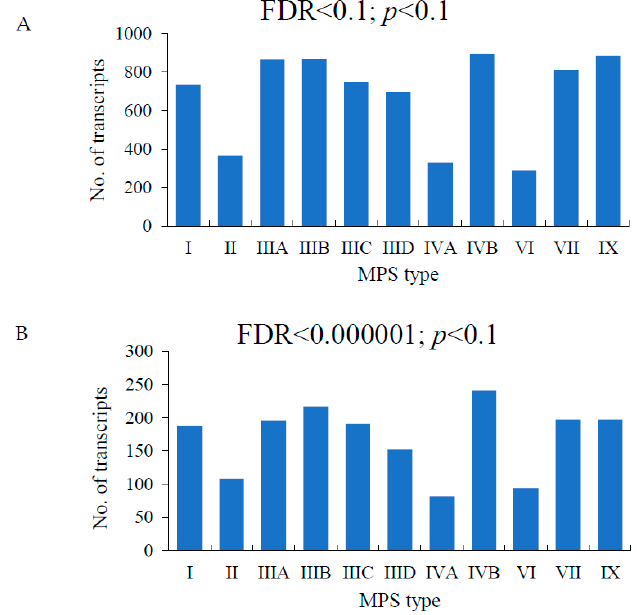
Figure 1. Number of transcripts with changed levels of expression (at FDR < 0.1; p < 0.1 ( A ) or FDR < 0.000001; p < 0.1 ( B )) in different types of MPS relative to control cells (HDFa). FRD — false discovery rate; MPS — mucopolysaccharidosis.